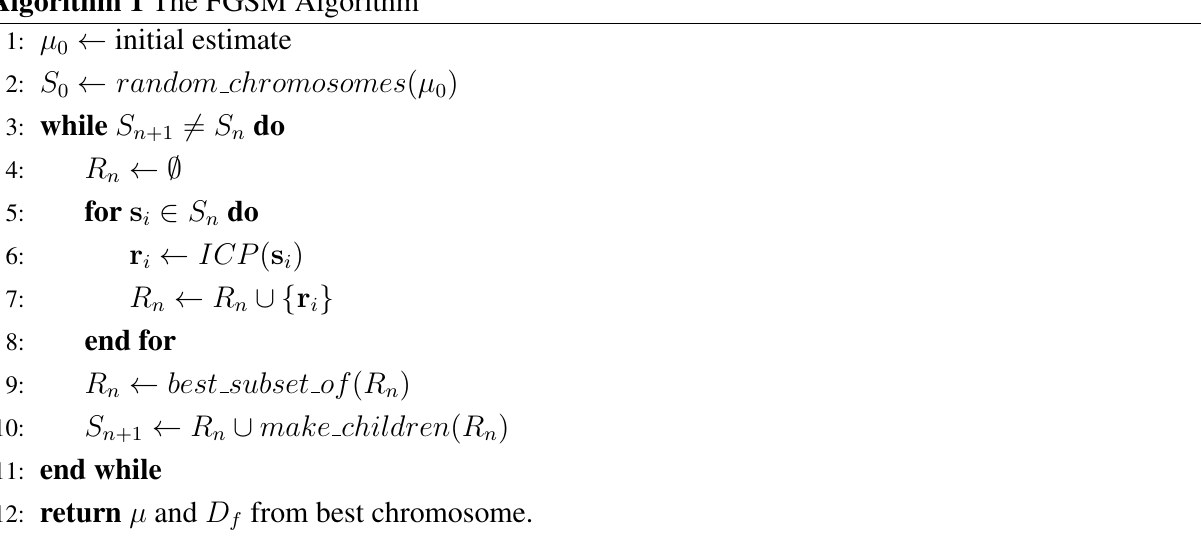
Algorithm 1 The FGSM